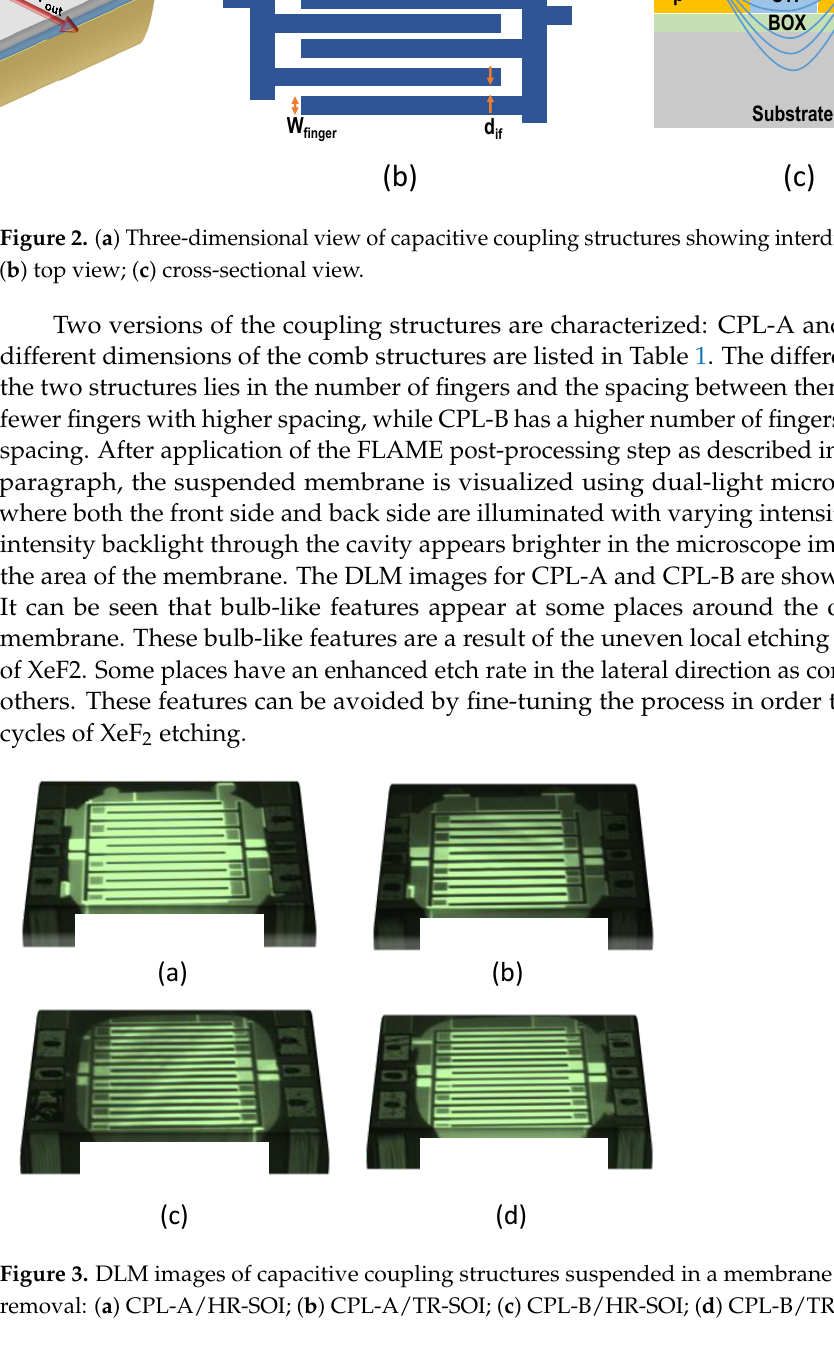
Figure 3. DLM images of capacitive coupling structures suspended in a membrane after substrate removal: ( a ) CPL-A/HR-SOI; ( b ) CPL-A/TR-SOI; ( c ) CPL-B/HR-SOI; ( d ) CPL-B/TR-SOI.